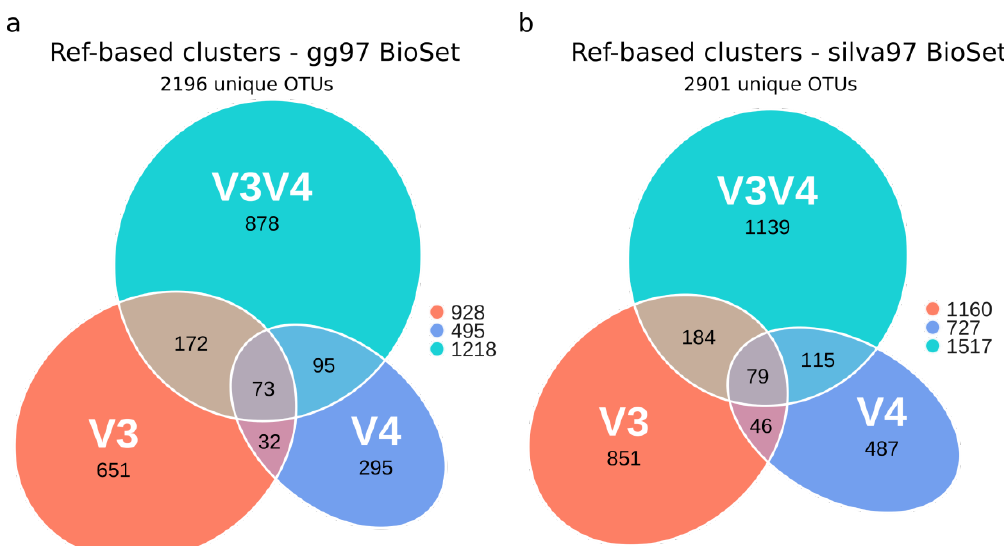
Figure 2. Euler diagram of unique operational taxonomic units (OTUs) captured by the V3, V4, and V3V4 regions in the gg97 and silva97 experimental BioSets. Only reference-based clusters were considered. ( a ) OTUs for the gg97 BioSet. ( b ) OTUs for the silva97 BioSet. The numbers of total unique clusters were indicated in the legend for each hypervariable region.